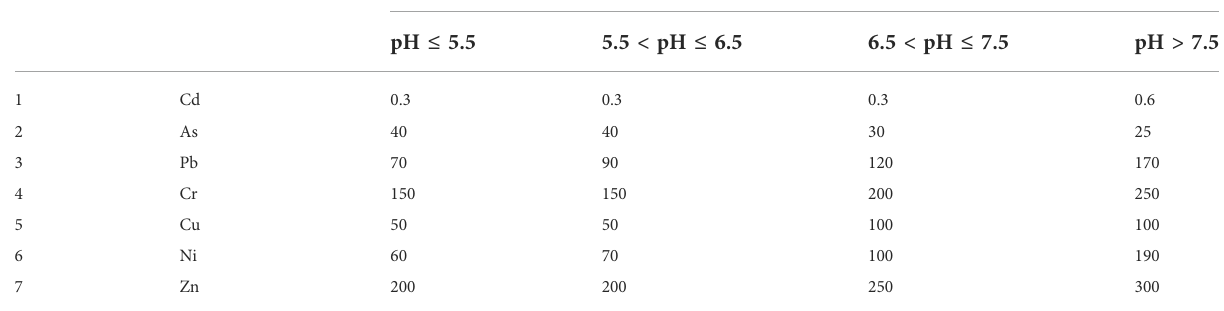
TABLE 2 Soil pollution risk screening value of agricultural land.